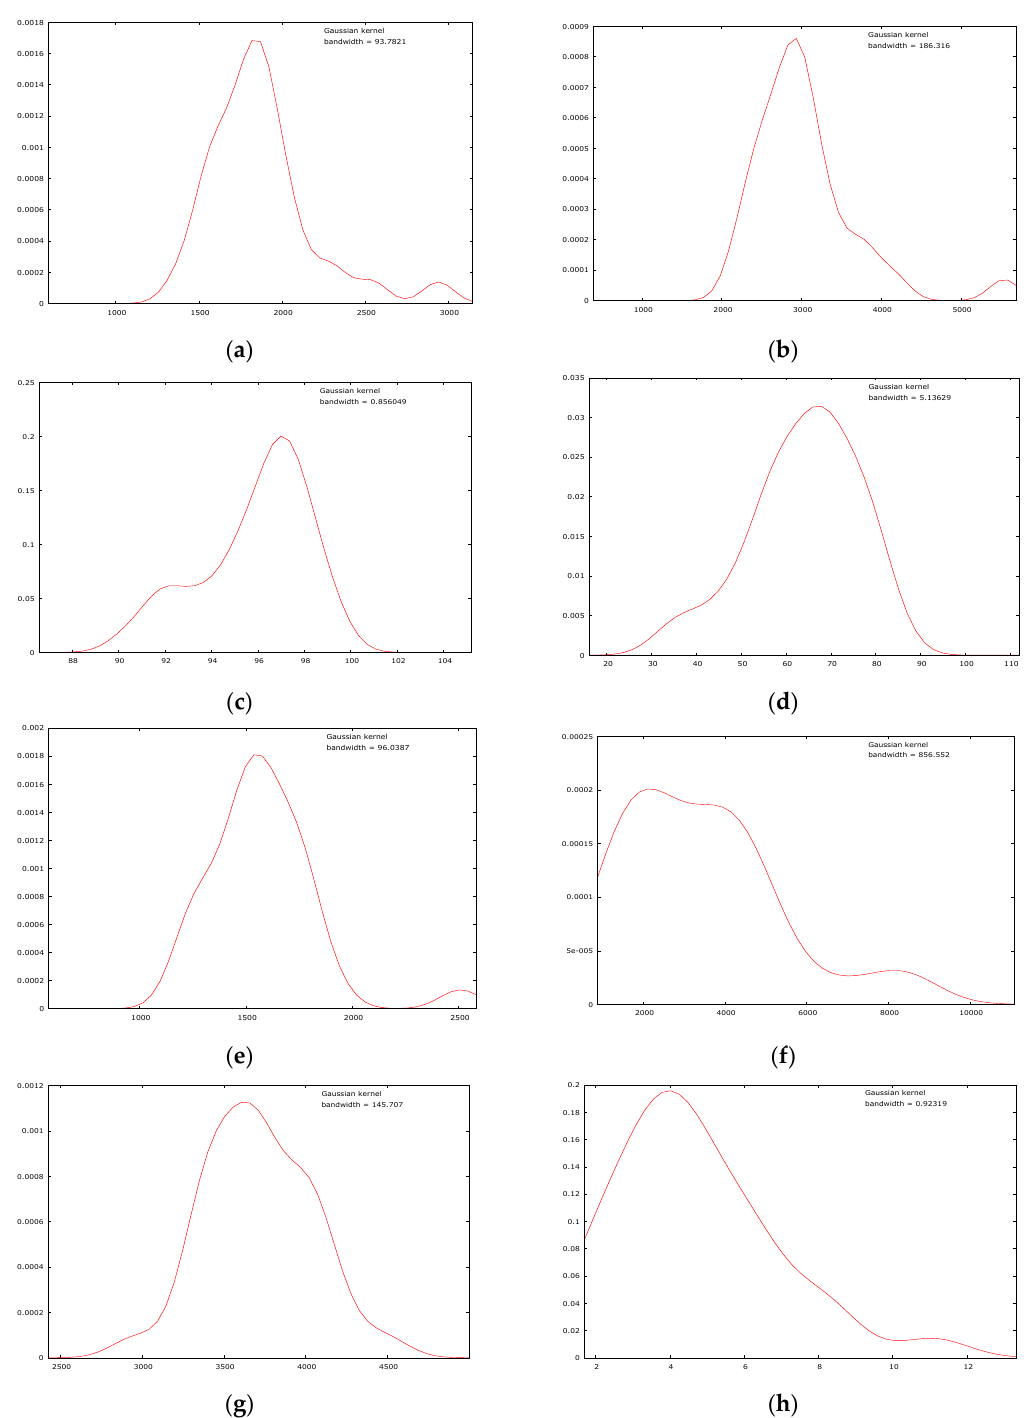
Figure 4. ( a ) Estimated density for the variable x 1 — own revenue of municipal budgets in the district at the regional level. ( b ) Estimated density for the variable x 2 — population per public pharmacy at regional level. ( c ) Estimated density for the variable x 3 — share of population served by water supply at regional level. ( d ) Estimated density for the variable x 4 — share of population served by a sewerage network at regional level. ( e ) Estimated density for the variable x 5 — entities of the national economy per 10,000 of population in working age at the regional level. ( f ) Estimated density for the variable x 6 — investment outlays in enterprises per capita at regional level. ( g ) Estimated density for the variable x 7 — average monthly gross wages and salaries at regional level. ( h ) Estimated density for the variable x 8 — registered unemployment rate at regional level.